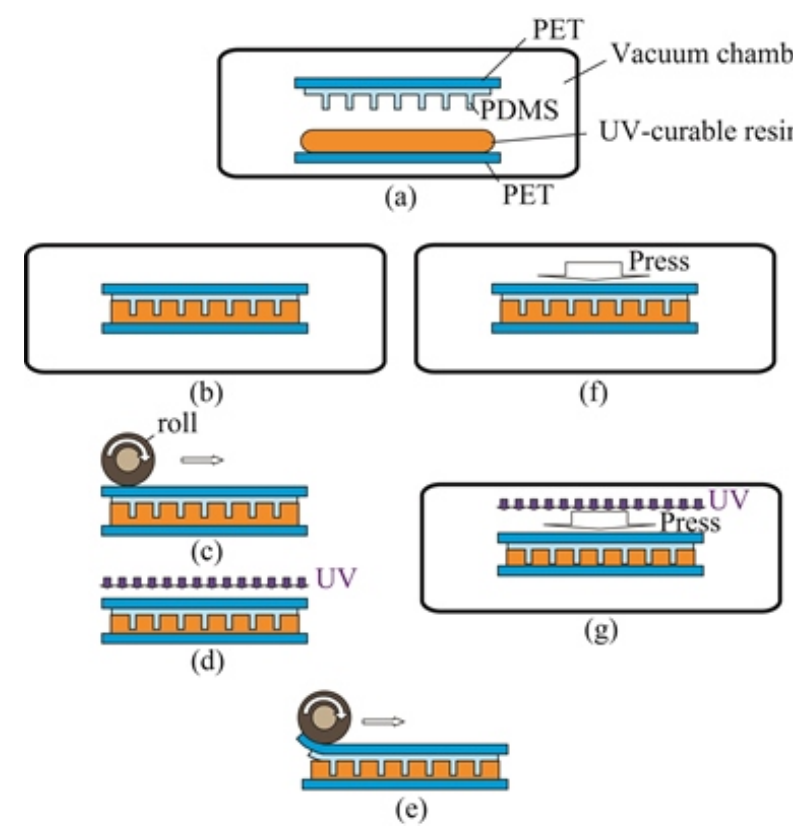
Figure 3. UV imprinting process: ( a ) placing PDMS mold and UV-curable resin-coated polyethylene terephthalate (PET) in a vacuum chamber; ( b ) moving mold and resin into contact under reduced pressure; ( c ) pressing by rotating roll; ( d ) UV irradiation; ( e ) peeling off mold along roll; ( f ) pressing mold and resin under reduced pressure; ( g ) UV irradiation and pressing. The roll press method includes ( a ), ( b ), ( c ), ( d ) and ( e ), and the batch press method includes ( a ), ( f ), ( g ) and ( e